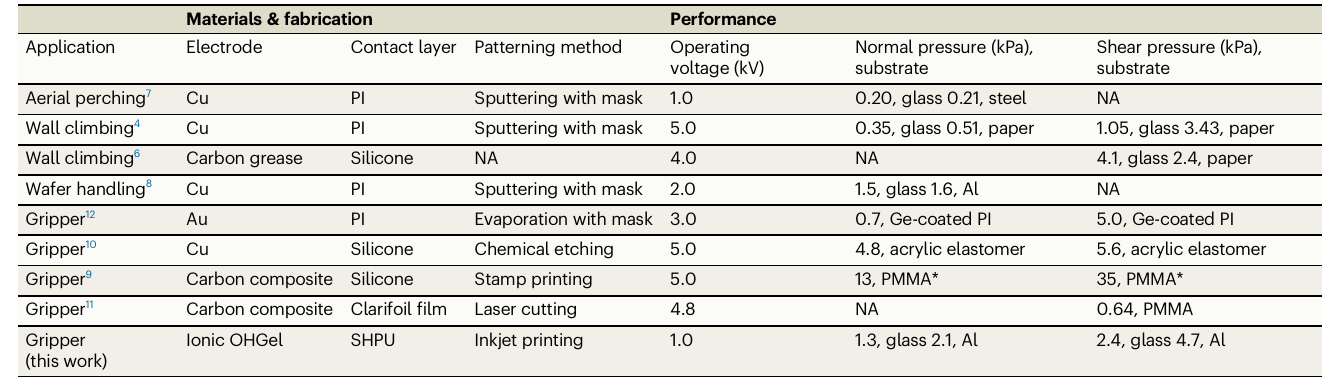
Table 1 | Comparison of state-of-the-art electrostatic adhesive devices Materials & fabrication Performance